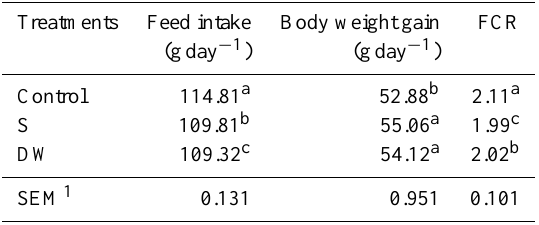
Table 3. The effect of sumac and whey powder on growth perfor- mance of female broiler